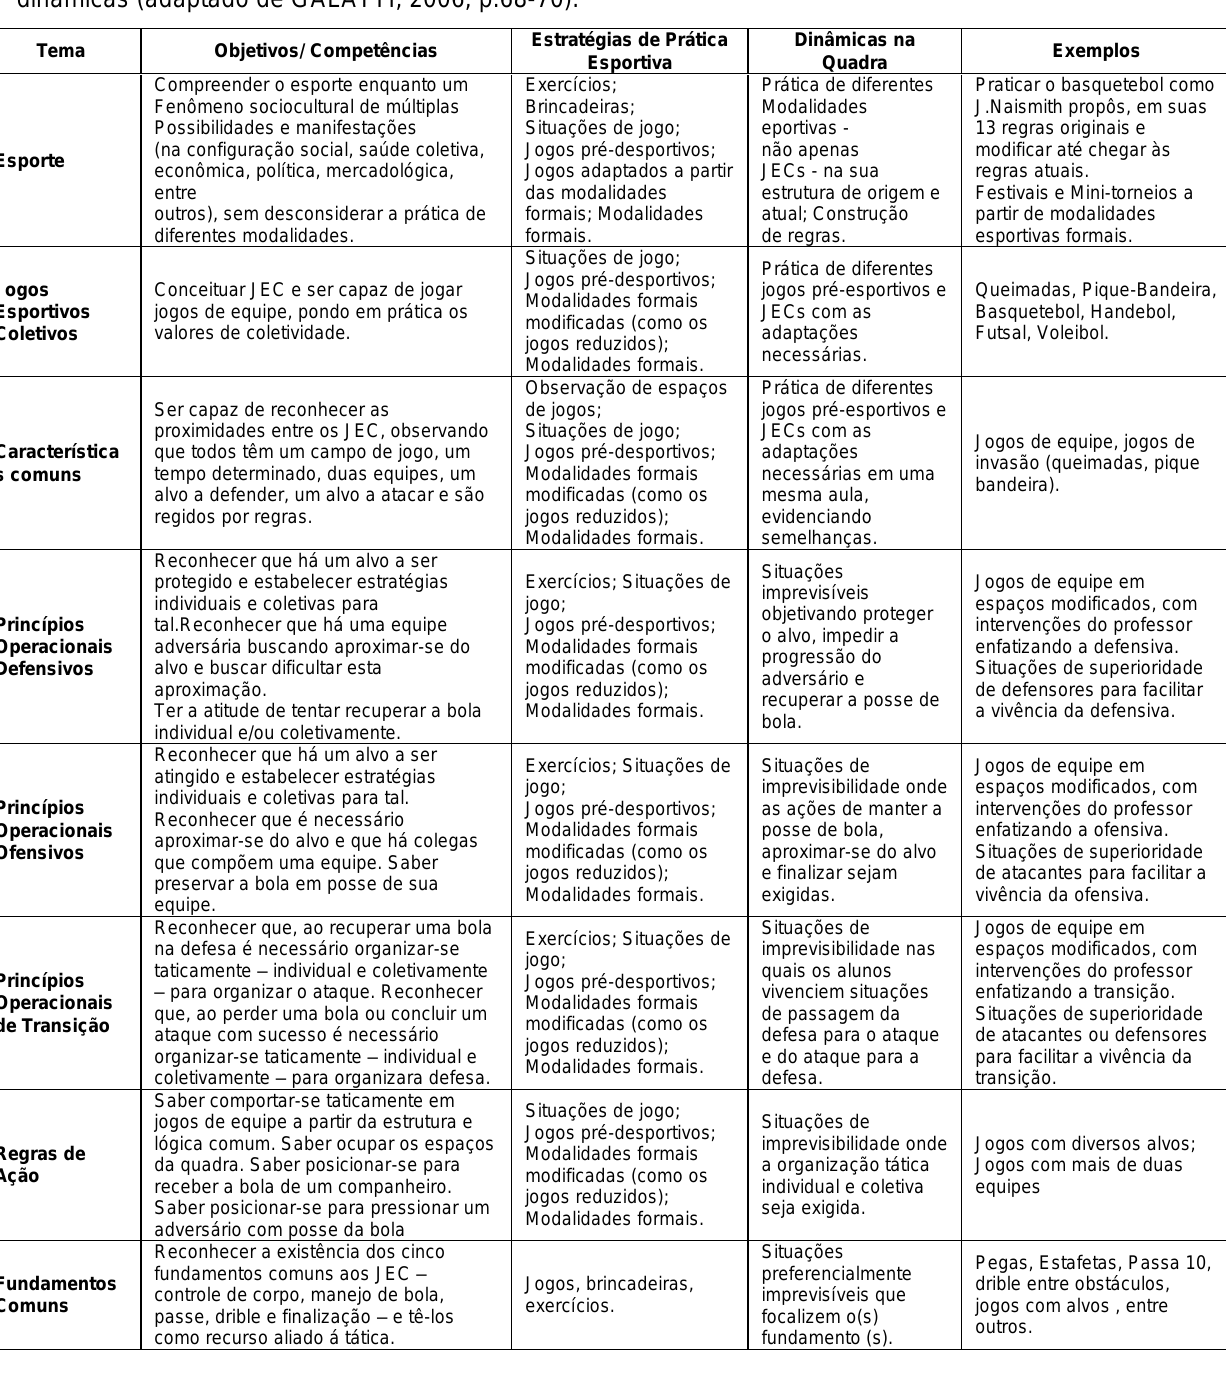
Tabela 1. Possíveis Temas Gerais para a prática dos JECs: objetivos, competências, estratégias e dinâmicas (adaptado de GALATTI, 2006,